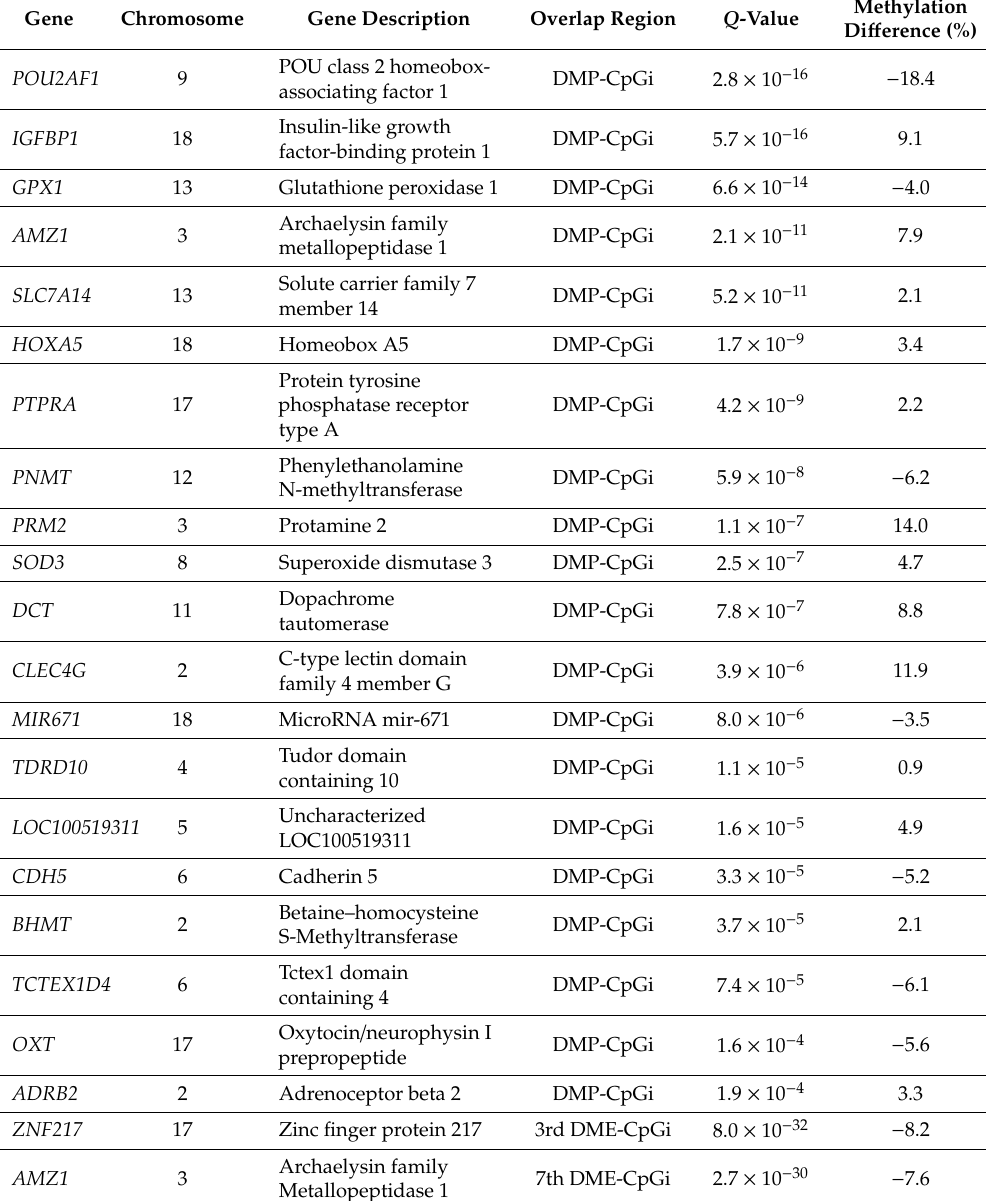
Table 2. Top 20 DMP-CpGi-related, DME-CpGi-related and DMI-CpGi-related